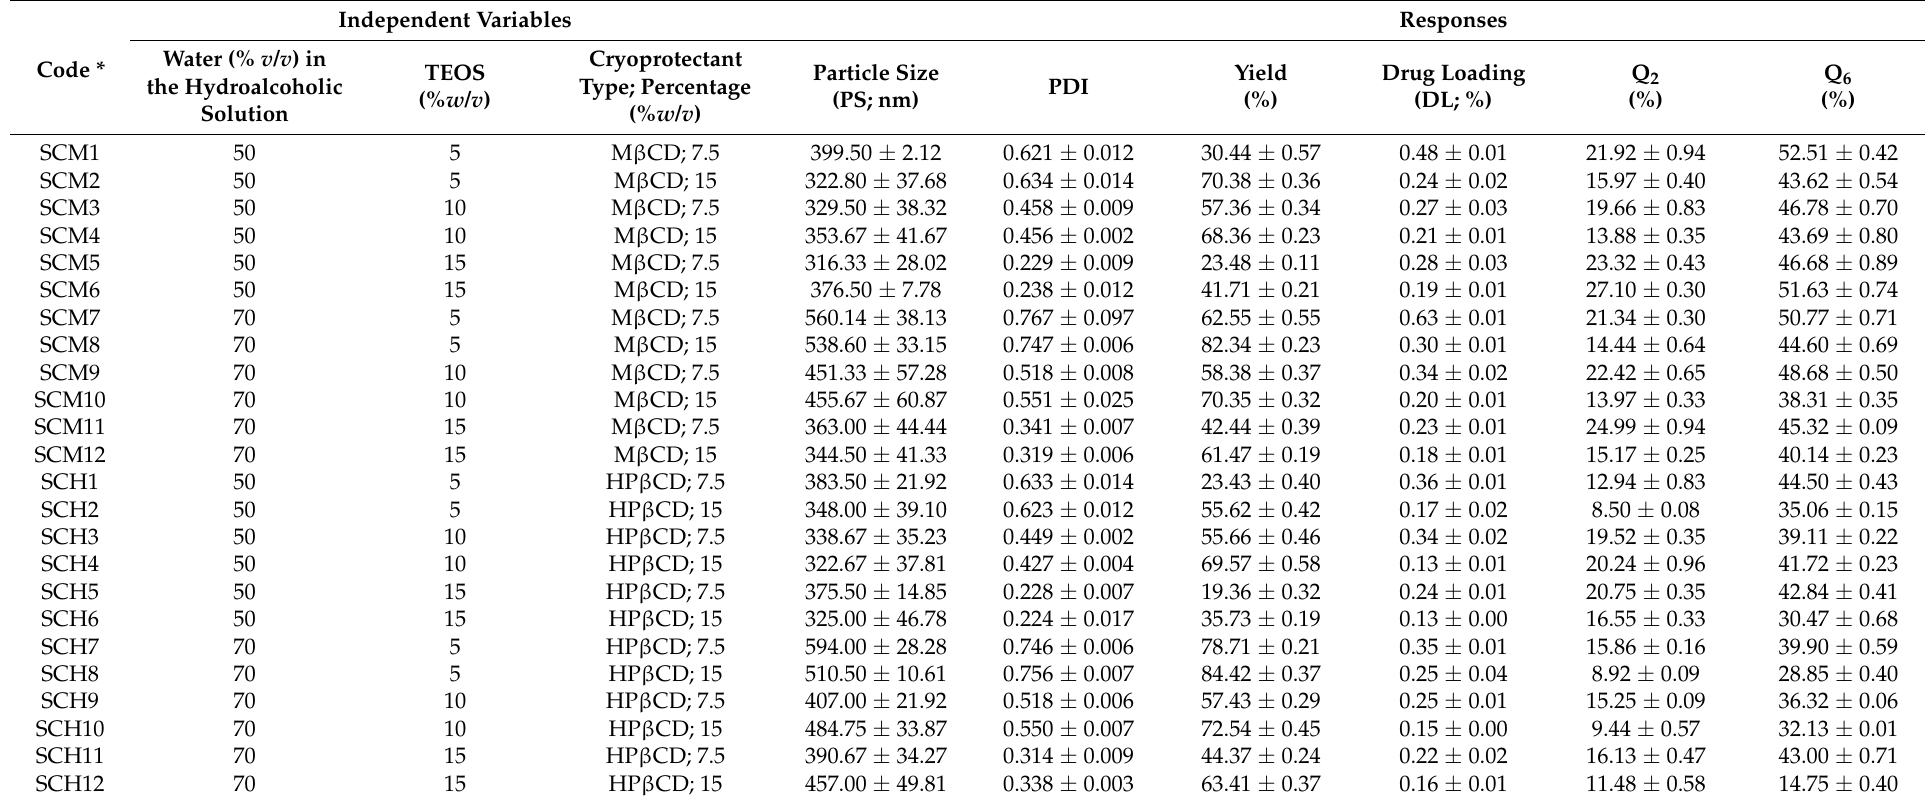
Table 1. Experimental runs and responses obtained for the factorial design of the freeze-dried terconazole-loaded silica/chitosan